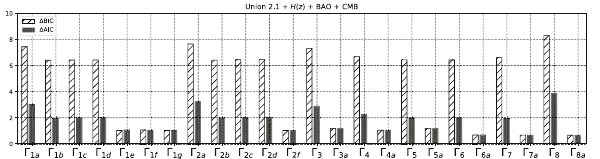
Fig. 1 (cid:9) AIC and (cid:9) BIC of models defined in Table 2 compared to (cid:2) CDM